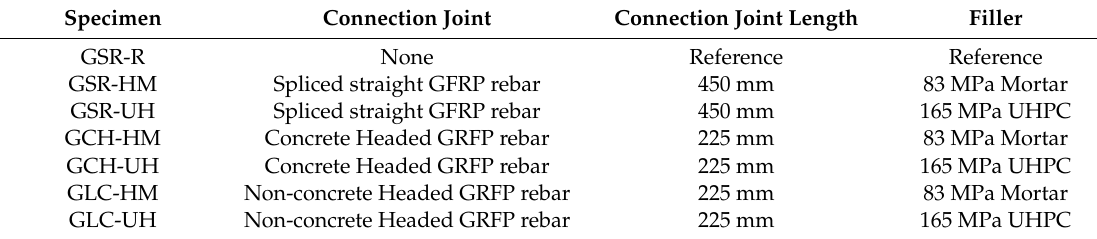
Table 4. Test variables for flexural test on the connected precast concrete